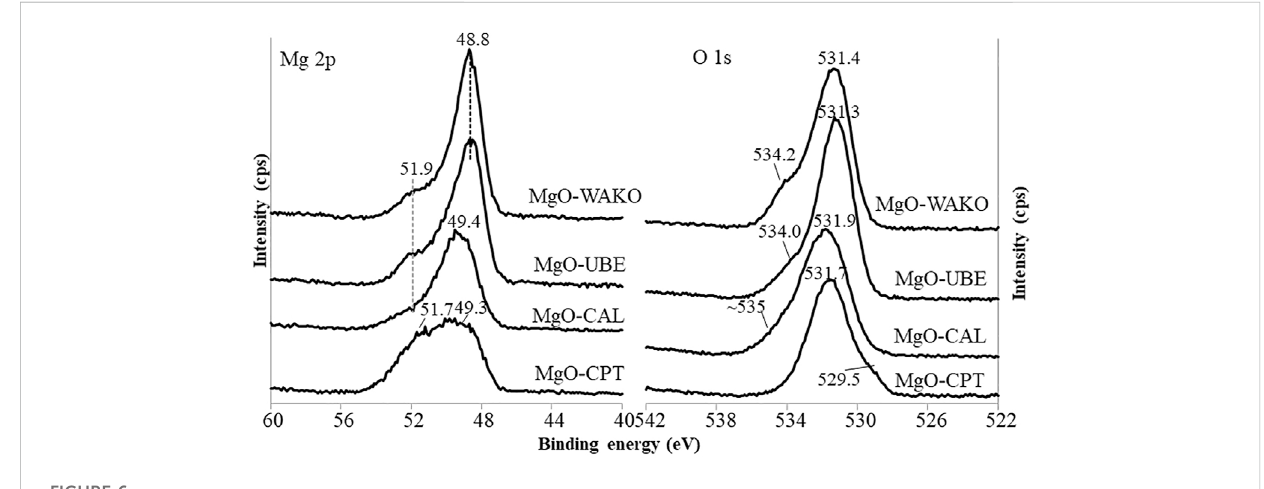
FIGURE 6 XPS pro fi les of different MgO catalysts.